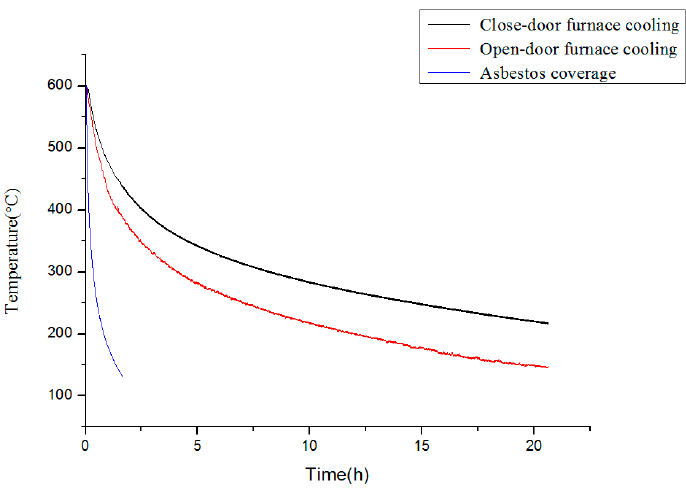
Figure 3. Time–temperature curves of different cooling ways.